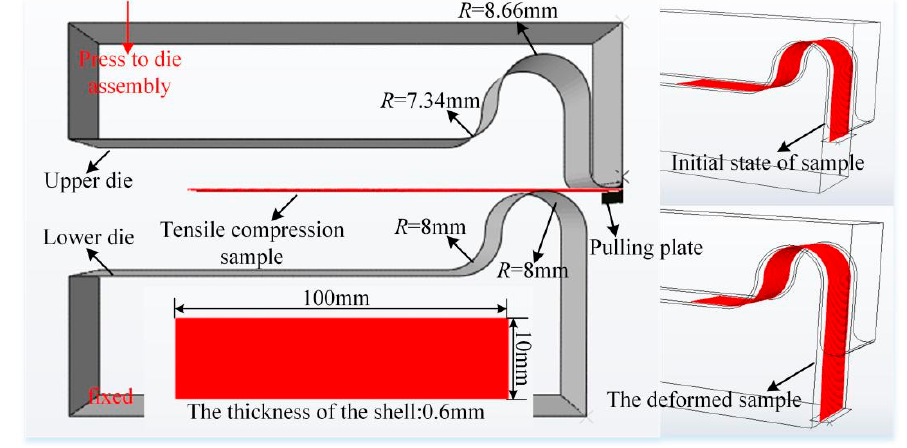
Figure 12. Finite element simulation